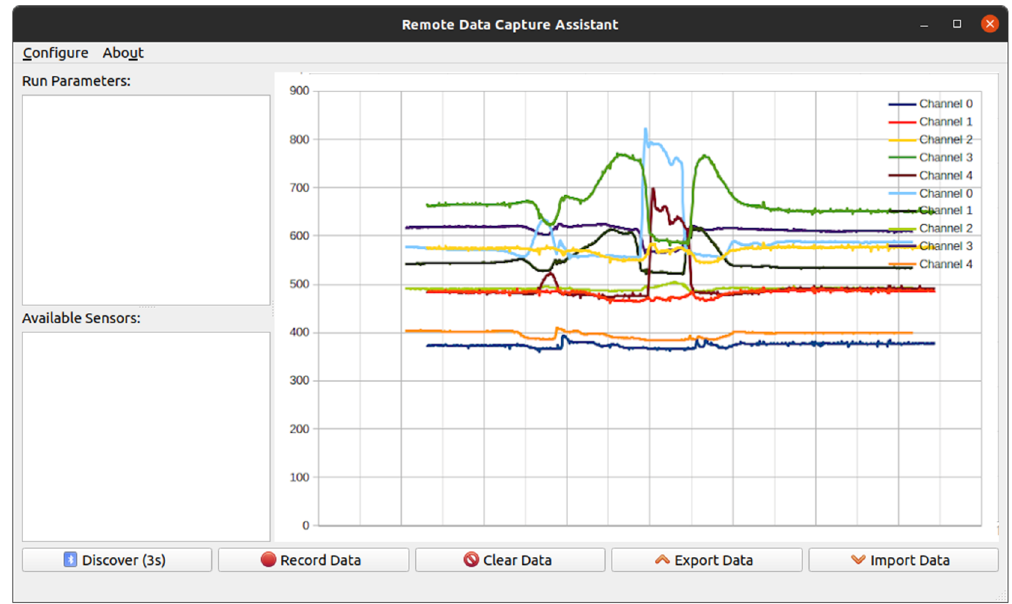
Figure 20. GUI (graphical user interface) design, displaying data from ten SRS.